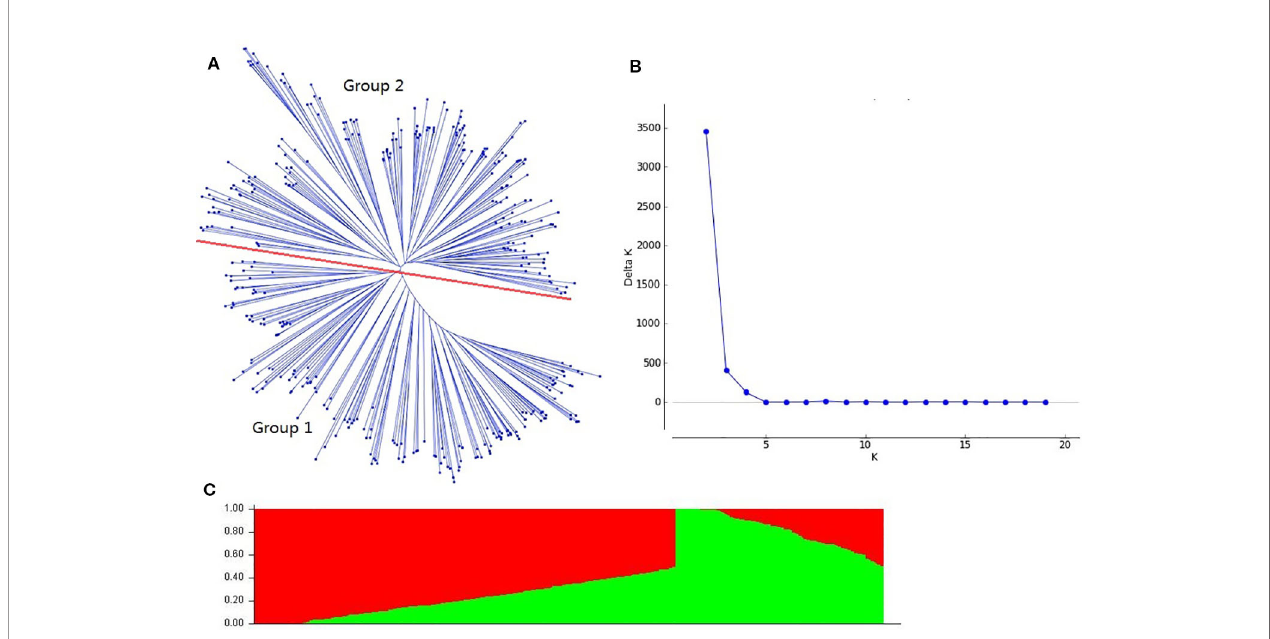
FIGURE 1 | Population structure of 384 wheat accessions based on 8,000 single nucleotide polymorphism (SNP) markers across whole genome. (A) : Neighbor- joining tree of the 384 accessions; (B) : Number of subpopulations estimated by delta K; (C) : Genetic structure produced by the STRUCTURE